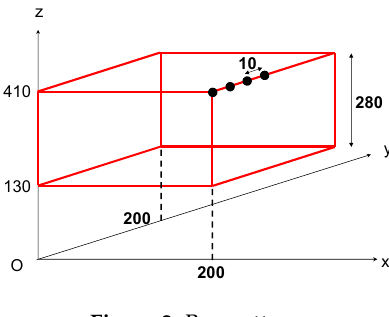
Figure 2. Box pattern.